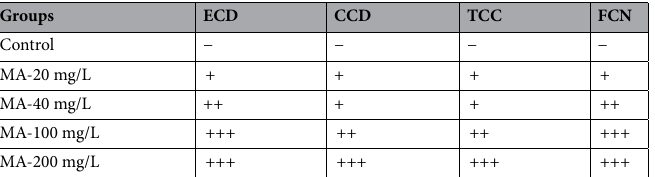
Table 3. Anatomical damage induced by metaldehyde. MA metaldehyde, ECD epidermis cell deformation, CCD cortex cell deformation, TCC thickening of the cortex cell wall, FCN flattened cell nucleus. (−): no damage, (+): little damage, (++): moderate damage, (+++): severe damage.